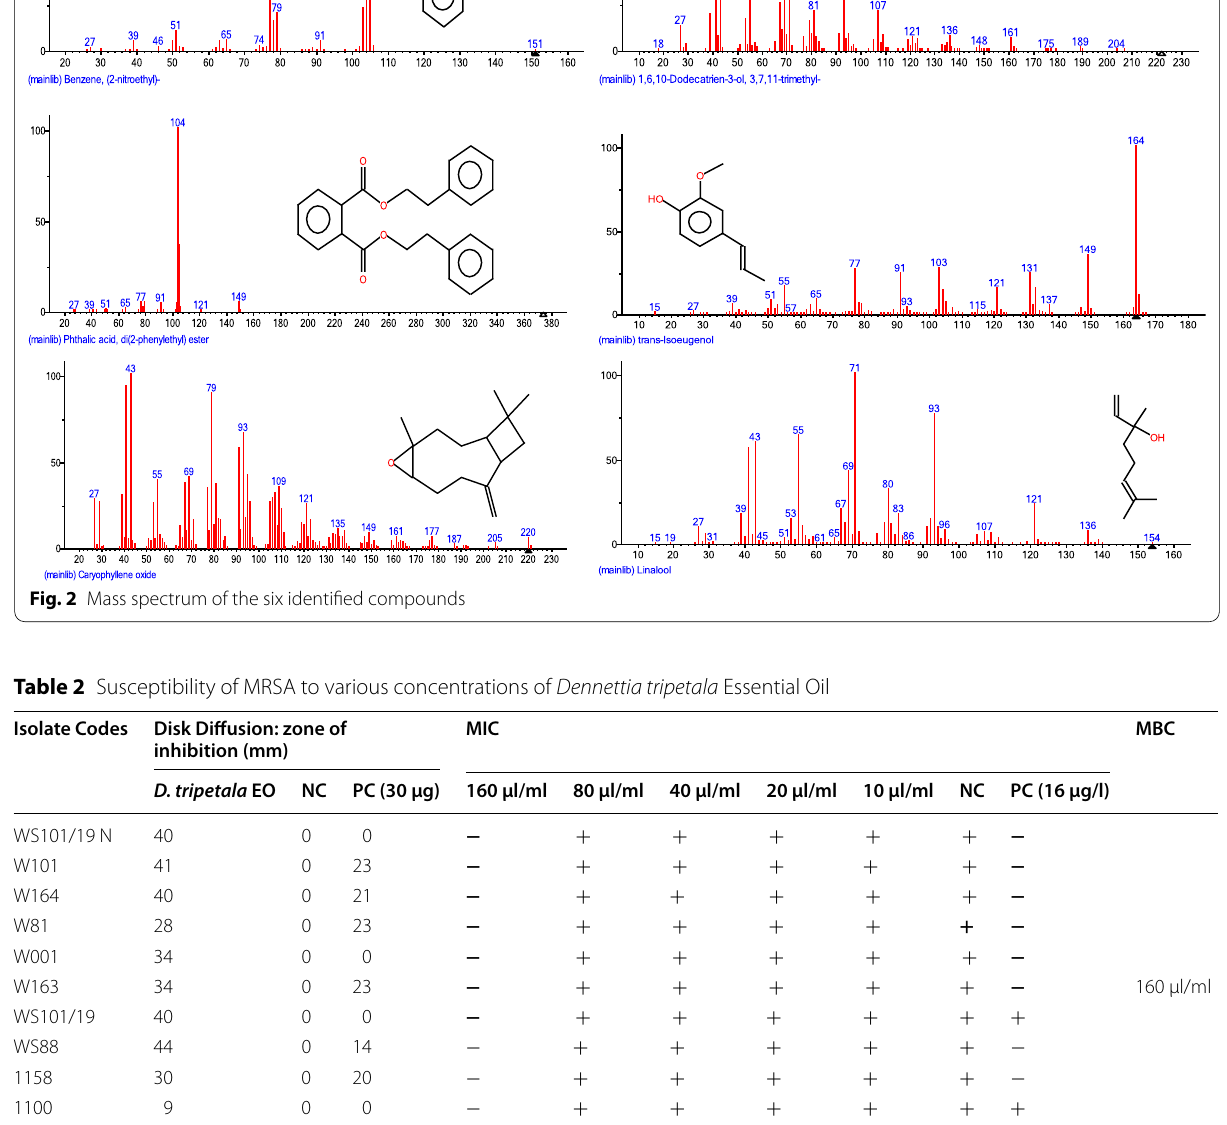
NC Negative control (undiluted coconut oil),—(No visible growth), 16 µg/ml)